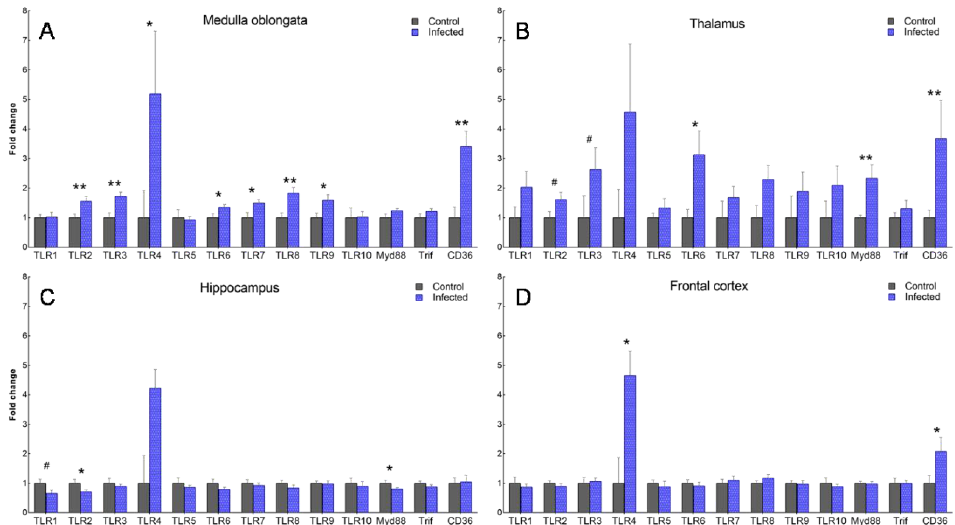
Figure 6. Gene expression of TLR 1-10 , MyD88, Trif, and CD36 in the medulla oblongata ( A ), thalamus ( B ), frontal cortex ( C ), and hippocampus ( D ) of control and scrapie-infected sheep. Data are represented as the mean fold ± SEM increase with respect to control sheep (expressed as a score of 1). Mean scores were compared using the Student’s t -test or Mann–Whitney U test for normally and non-normally distributed data, respectively. # p < 0.1, * p < 0.05, ** p < 0.01.